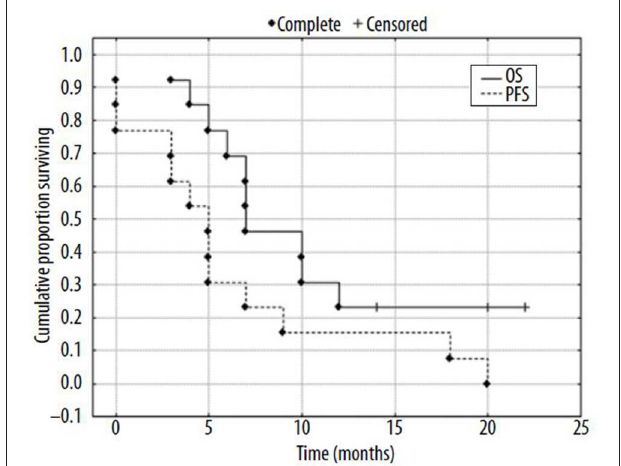
FIGURE 8 | Kaplan-Mayer surviving curves for patients ( N = 13) after radioembolization of liver tumors with 188 Re-HSA microspheres [from Nowicki et al. (207), available under the terms of the Creative Commons Attribution Non Commercial-No Derivs 3.0 (CC BY-NC-ND 3.0)].